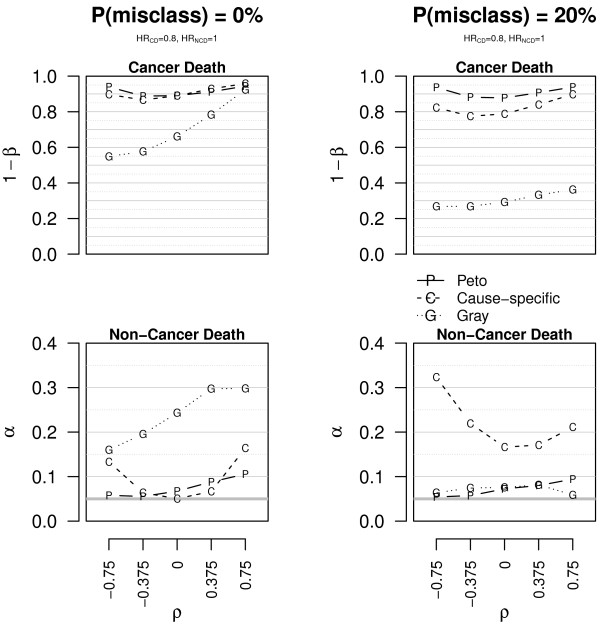
Empirical power and size of the tests in scenario 3. Empirical power (1 - β) and size (α) of the tests for CD and NCD in scenario 3 (HRCD = 0.8, HRNCD = 1). The data are simulated without censored observations. The plots on the first line concern CD, those on the second line NCD. The plots on the left are for data with correct causes of death (P(misclass) = 0%), those on the right for data with 20% of misclassified causes of death (P(misclass) = 20%). The bold grey horizontal line corresponds to the 0.05 level and ρ to the correlation.